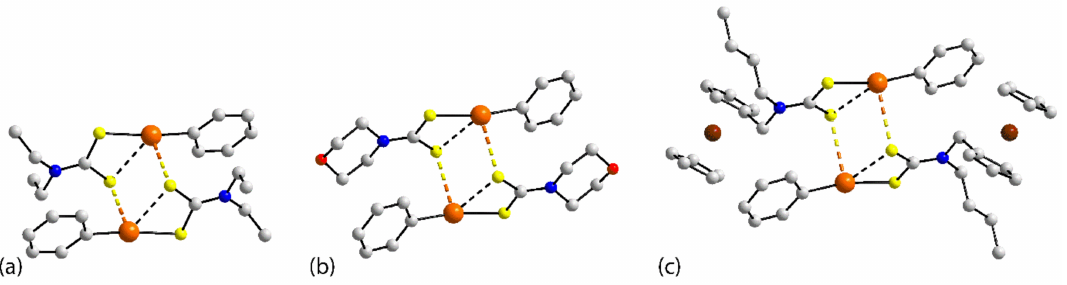
Figure 3. Supramolecular association in zero-dimensional aggregates featuring two Hg ··· S interac- tions: ( a ) 4 , ( b ) 8 and ( c ) 7 . Additional colour code: